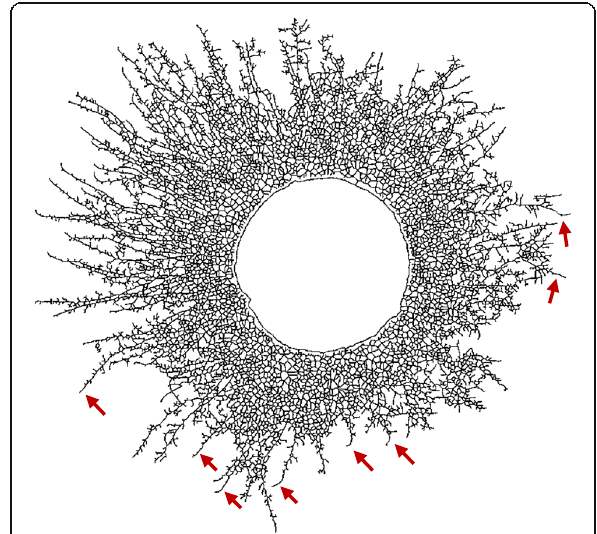
Fig. 9 Elongation of hyphal segments at the periphery of the mycelium. Binary image, representing the mycelium of R. solani after 30 h of growth, at 25 °C and 80%